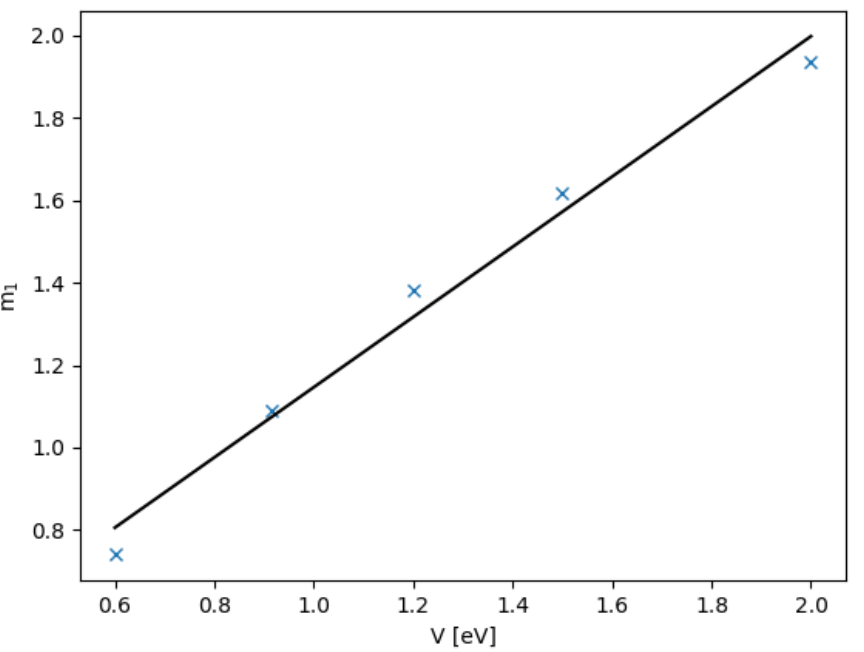
Figure 7. The slope m 1 as a function of the potential V with linear fitting in solid line as m 1 ( V ) = 0.852 V +